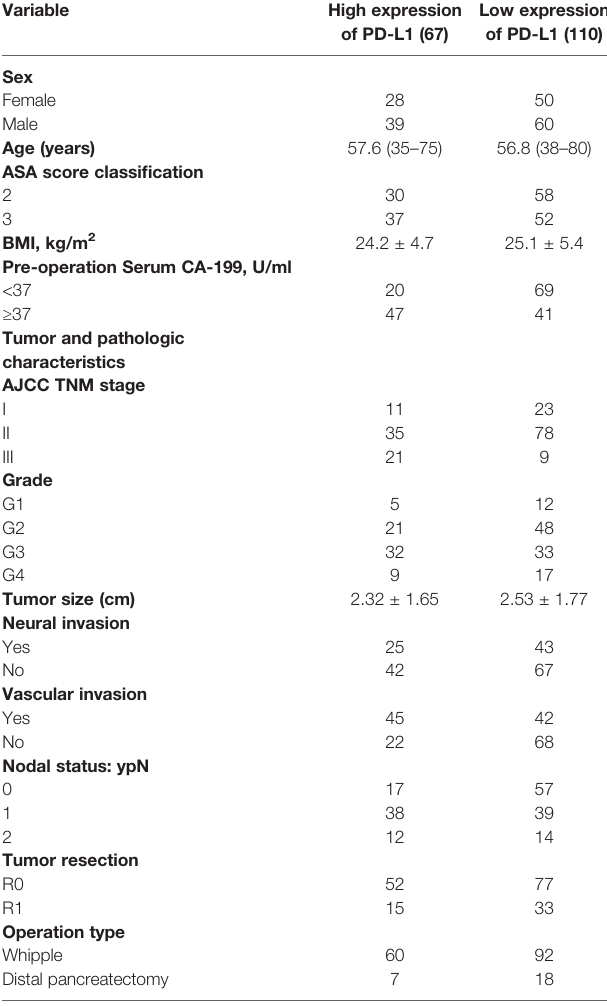
TABLE 1 | Demographics and baseline characteristics of patients with PDAC who underwent tumor resection.